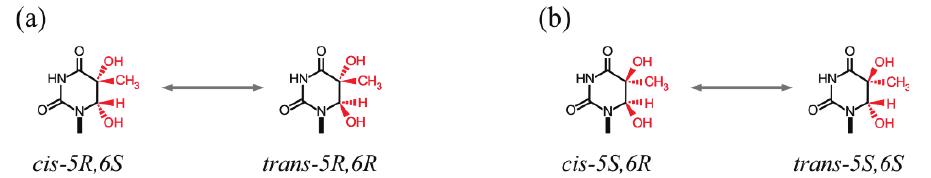
Figure 5. ( a ) cis-trans stereoisomer pair of 5R thymine glycol; ( b ) cis-trans stereoisomer pair of 5S thymine